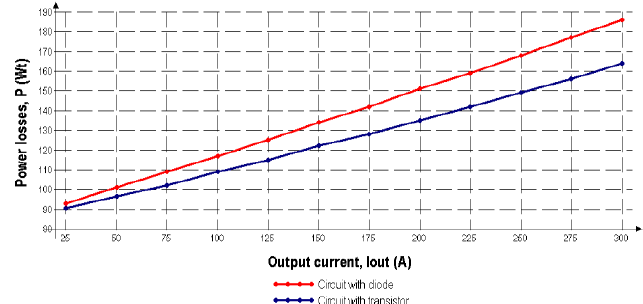
Fig. 11. Power losses in the circuits with diode and transistor depending on the output current.